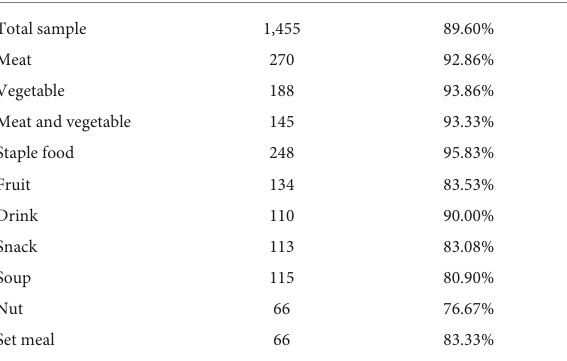
TABLE 3 Recognition accuracy rates of the Aliyun Cloud Food Recognition